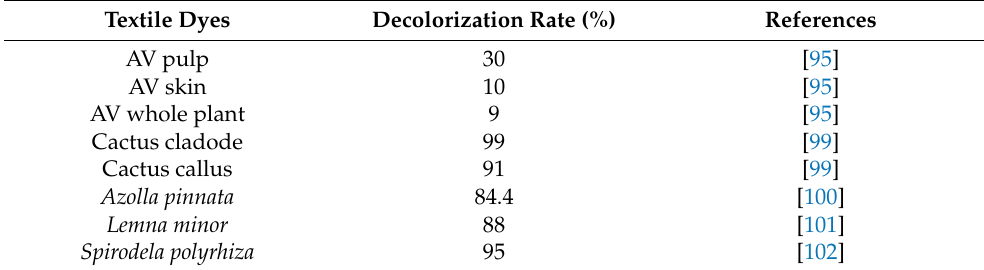
Table 5. Comparison of phytoremediation potential of various plants for malachite green degradation. Textile